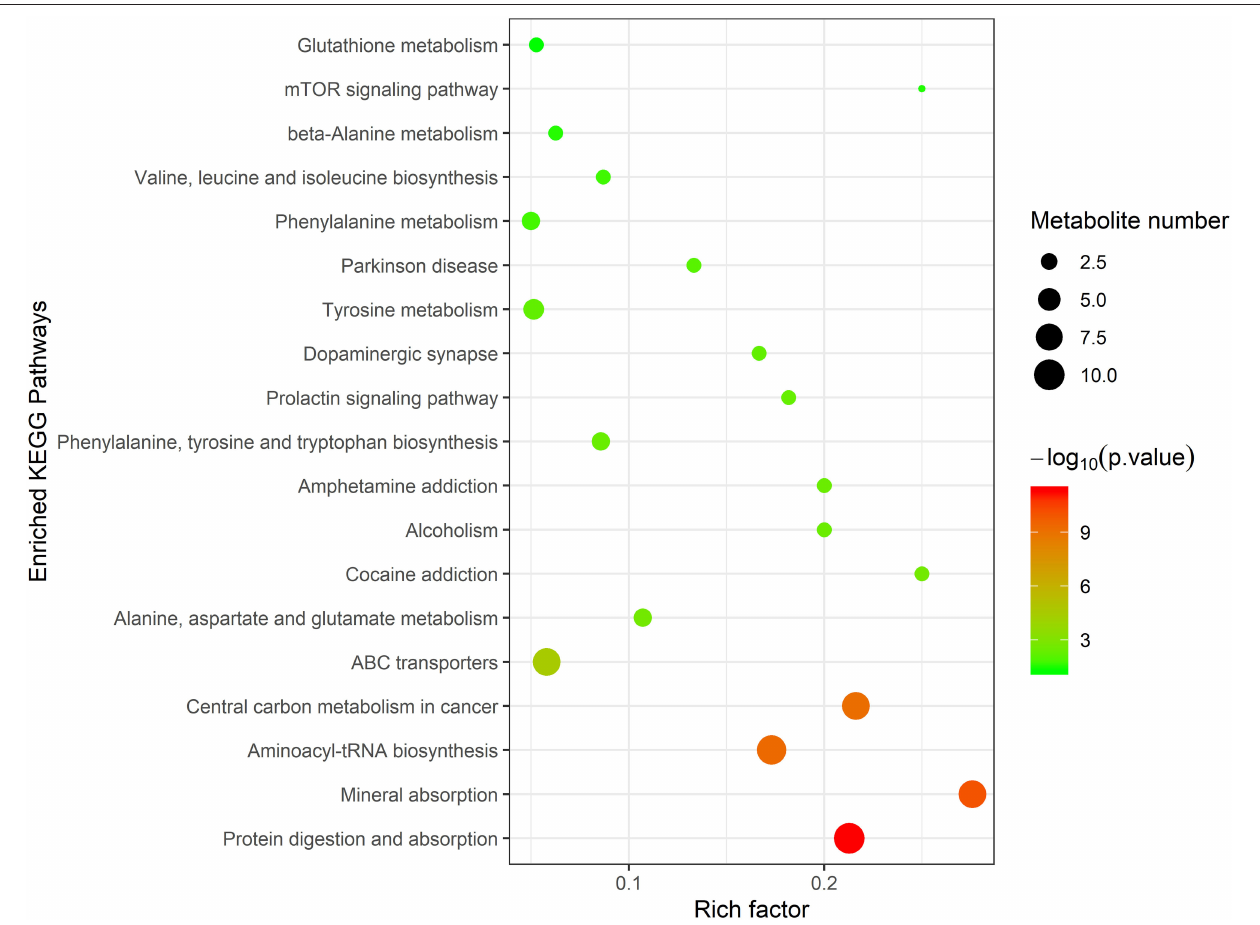
FIGURE 6 | Topology analysis of metabolic pathways identified among 1,050 mg/kg choline group, 1,850 mg/kg choline group, and 2,650 mg/kg choline group. The X-axis represents the rich factor, and the Y-axis represents the pathway. Larger sizes and darker colors represent greater pathway enrichment and higher pathway impact values,